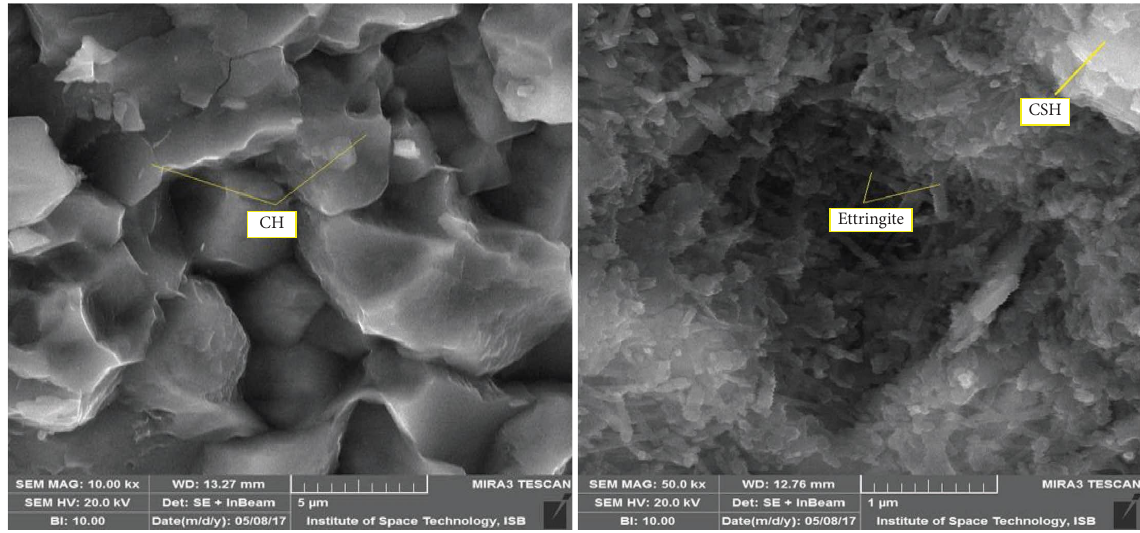
Figure 9: SEM of the NCASCC sample.